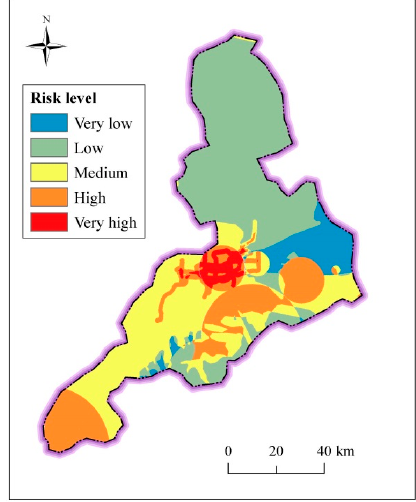
Figure 16. Spatial distribution of risk level of underground index. Table 8. Statistical risk level of underground index in different district.